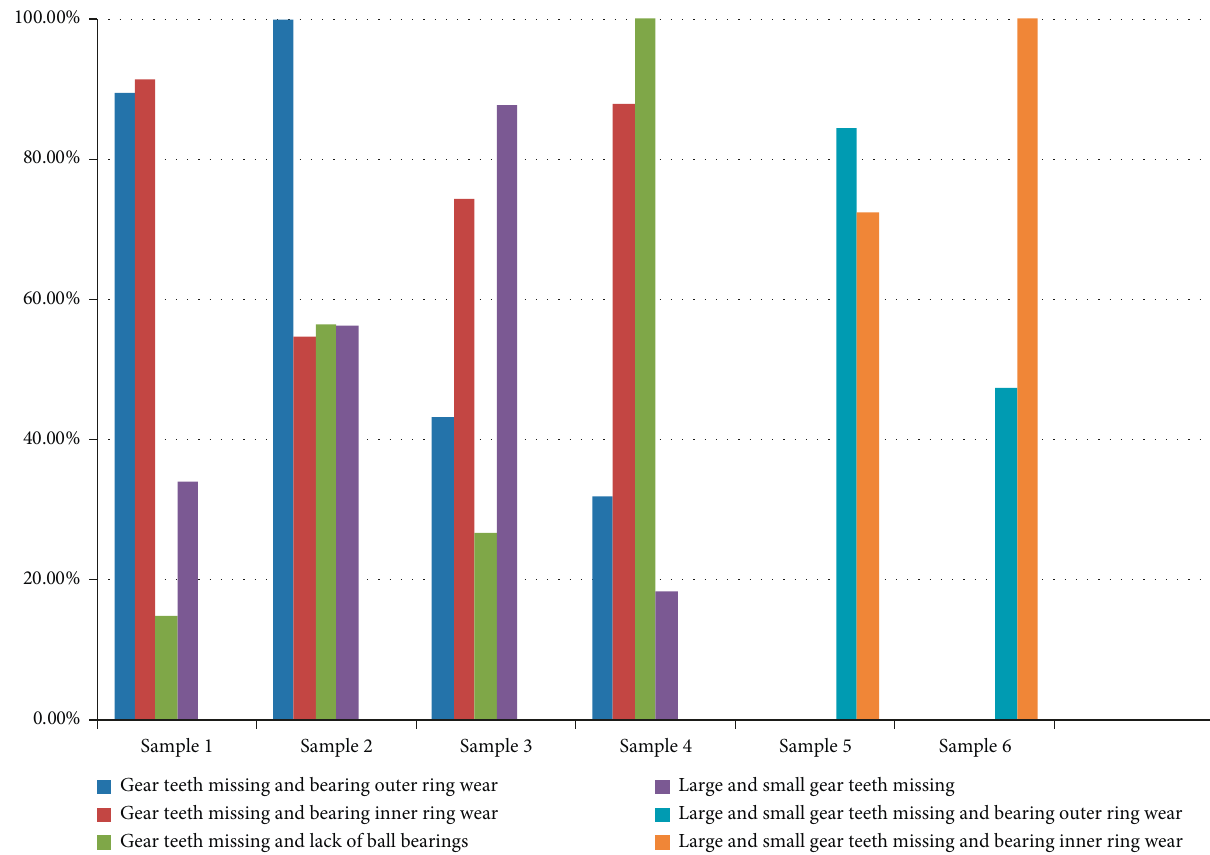
Figure 7: The result of evidence theory and multiple information